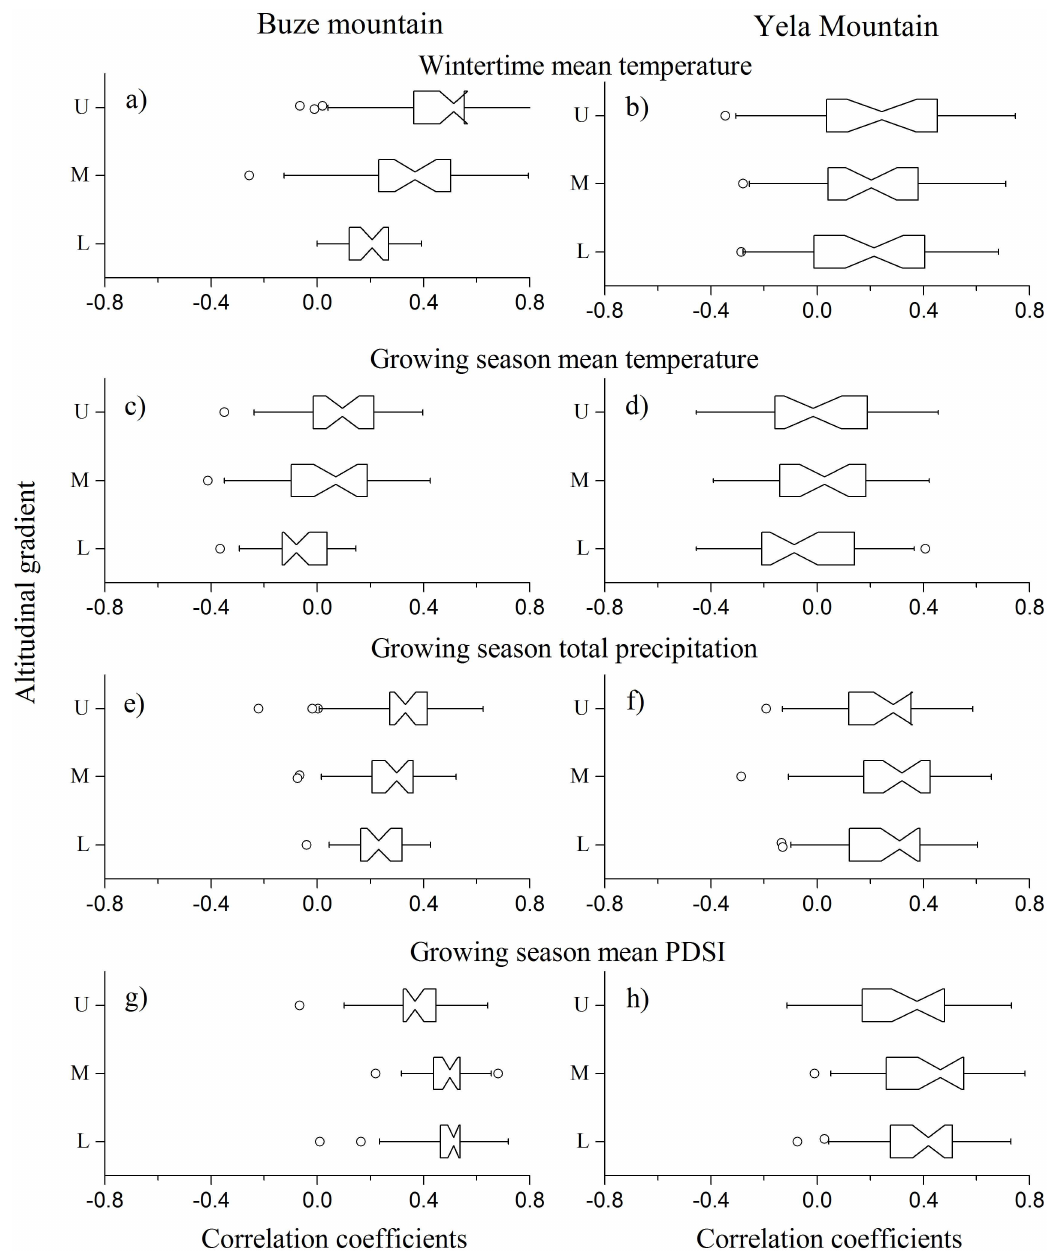
Fig 7. Box plot of the correlation coefficients between the climate data and growth indices of trees in Buze and Yela Mountains. The position of the notch represents the medianvalue; the right and left edges of the box represent the 1st and 3rd quartiles; circles outside of the line represent outliers (beyond1.5 interquartilerange of the box). If two notch boxes do not overlap, this indicatesa statistically significant difference between the two medians. L, M and U represent the lower, middle and upper